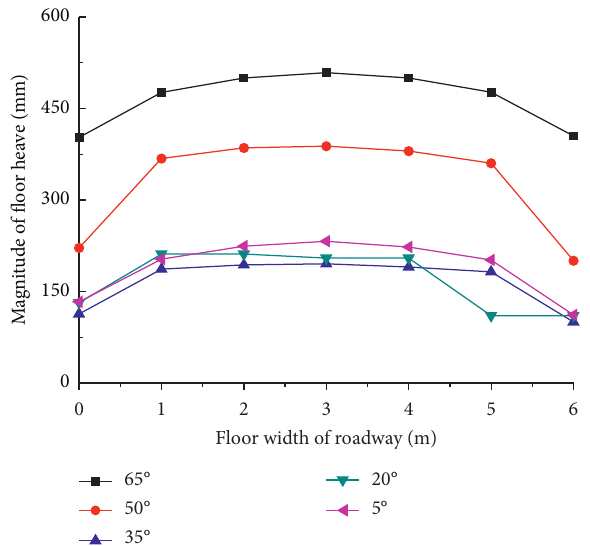
Figure 7: The magnitude of floor heave under different pile